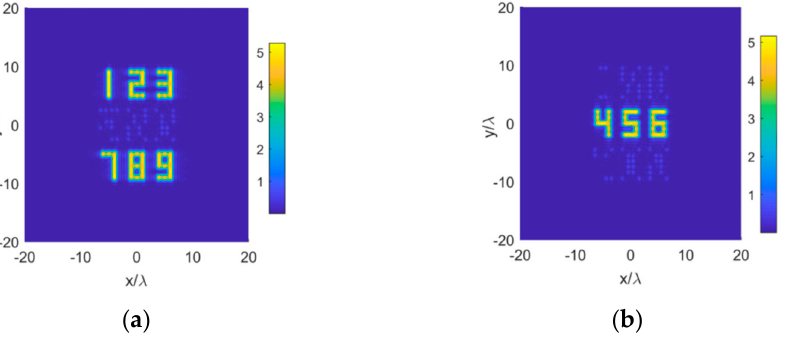
Figure 7. The reconstructed pictures of a source with two polarizations. ( a ) x -component and ( b ) y -component.